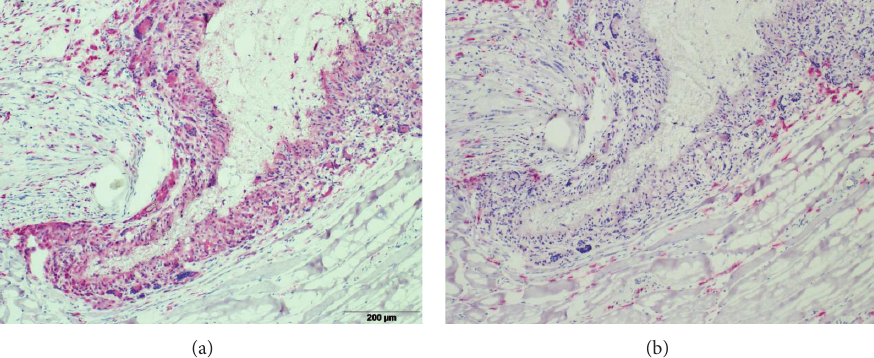
Figure 12: Exemplary immunohistochemical images for staining of CD68-positive total monocytes and macrophages (ED1, left) and CD163- positive tissue macrophages (ED2, right) from experimental day 14 for an untreated PLA mesh sample.